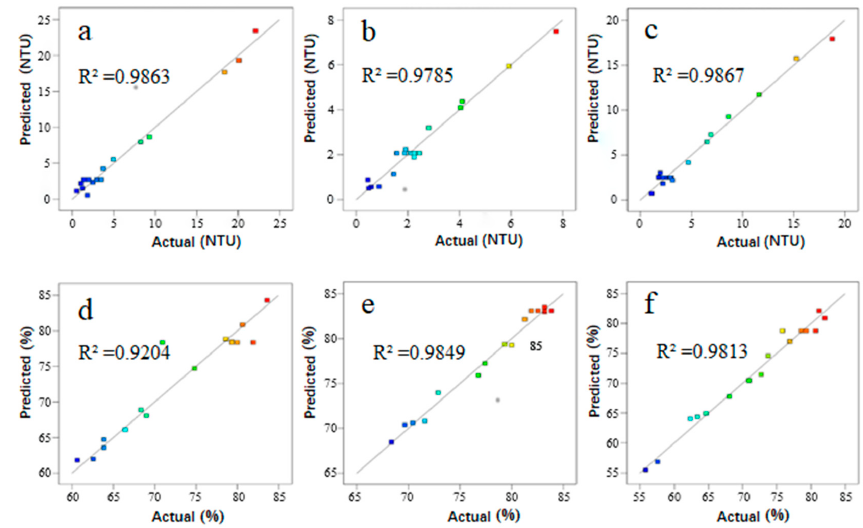
Figure 1. Plots of predicted values of the models versus actual values on different factors for residual turbidity: ( a ) Al/Si; ( b ) La/Si; ( c ) basicity and UV 254 removal; ( d ) Al/Si; ( e ) La/Si; ( f ) basicity.